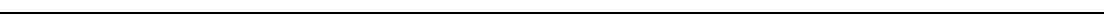
Fig. 7 SUMOylation of BARD1 occurs in a BRCA1-dependent manner. a , b U2OS cells stably expressing His10-SUMO2 were transfected either with siRNAs targeting BRCA1 and BARD1 or a control siRNA as indicated. After 3 days, the cells were treated with MG132 for 5 h and with Bleocin (5 µ g/ml) for 4 h, harvested, and His10-SUMO2 conjugates were puri fi ed from denaturing lysates. a Levels of SUMOylated and total BARD1 were determined by immunoblotting. b Levels of SUMOylated and total BRCA1 were determined by immunoblotting. c – e U2OS cells stably expressing His10-SUMO2 were infected with retroviruses expressing w.t. BARD1-GFP or the indicated point mutants and selected for puromycin resistance. Four days after antibiotic selection, the cells were re-plated. The next day, the cells were either infected with a lentivirus to knockdown RNF4 or with a control lentivirus. Three days after lentiviral infection, the cells were control treated ( c ), exposed to IR (10 Gy) ( d ), or treated with MG132 (10 µ M) or DMSO for 4 h ( e ), harvested, and lysed, and His10-SUMO2 conjugates were puri fi ed from denaturing lysates. Total levels of BARD1-GFP and SUMOylated levels were determined by immunoblotting using antibodies directed against GFP. Experiments were independently repeated. The enrichment of His10-SUMO2 conjugates was veri fi ed by immunoblotting as shown in Supplementary Fig. 7. Unprocessed full-size scans of blots are provided in Supplementary Fig. 9. Experiments presented in a and b were performed three times. Experiments described in c – e were performed two times. Unprocessed full-size scans of blots are provided in Supplementary Fig.